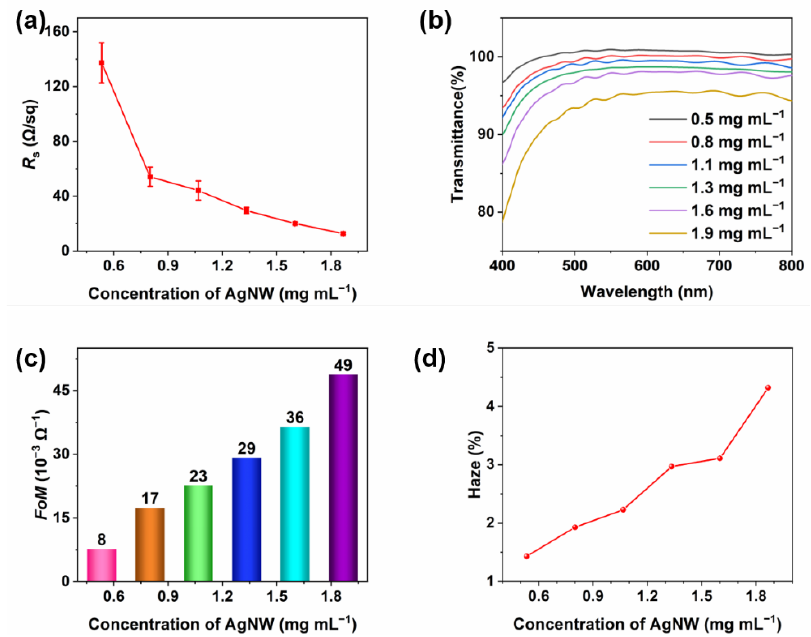
Figure 4. Optoelectronic properties of the AgNW film produced at different AgNW concentrations: ( a ) the R s of the AgNW films; ( b ) the transmittance of the AgNW films from 400 to 800 nm; ( c ) the FoM ; ( d ) the haze values of the AgNW films.